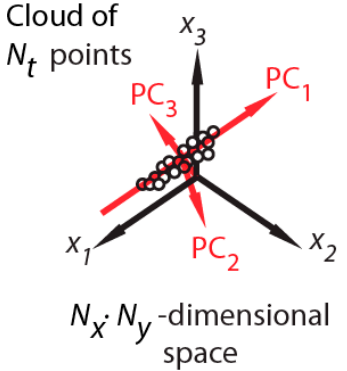
Figure 3. Explanation of Principal Components (only three dimensions are shown). Red arrows indicate the directions of the first three principal components [24].